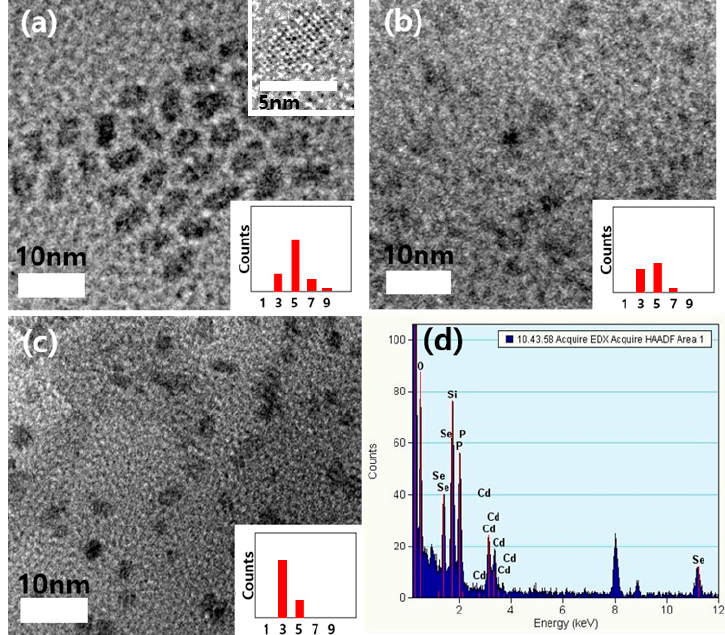
Figure 1. TEM micrographs of red, yellow and green QDs ( a – c ) and EDX analysis data ( d ) for red QDs; Inset for ( a – c ) shows the distribution of particle sizes.